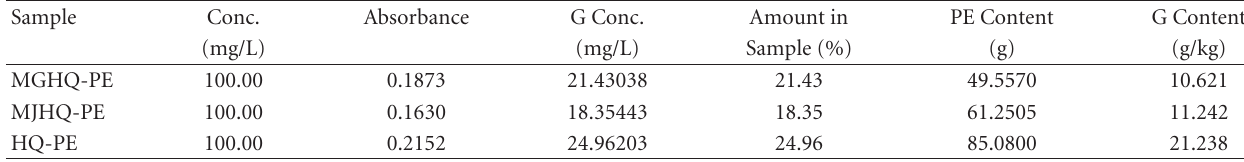
Table 3: Polysaccharide content in MGHQ, MJHQ and